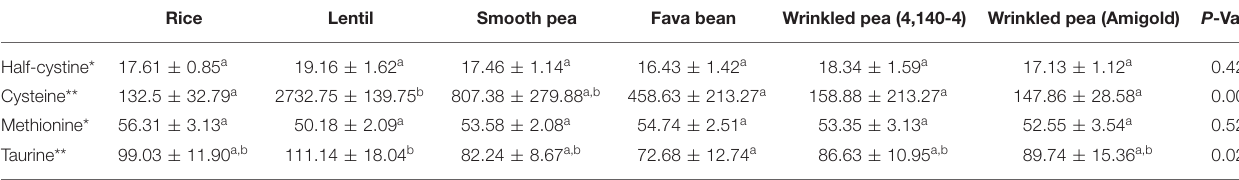
TABLE 6 | Plasma amino acid levels of taurine, half-cystine, cysteine and methionine observed in fasted dogs after 7 days of feeding each test diet.